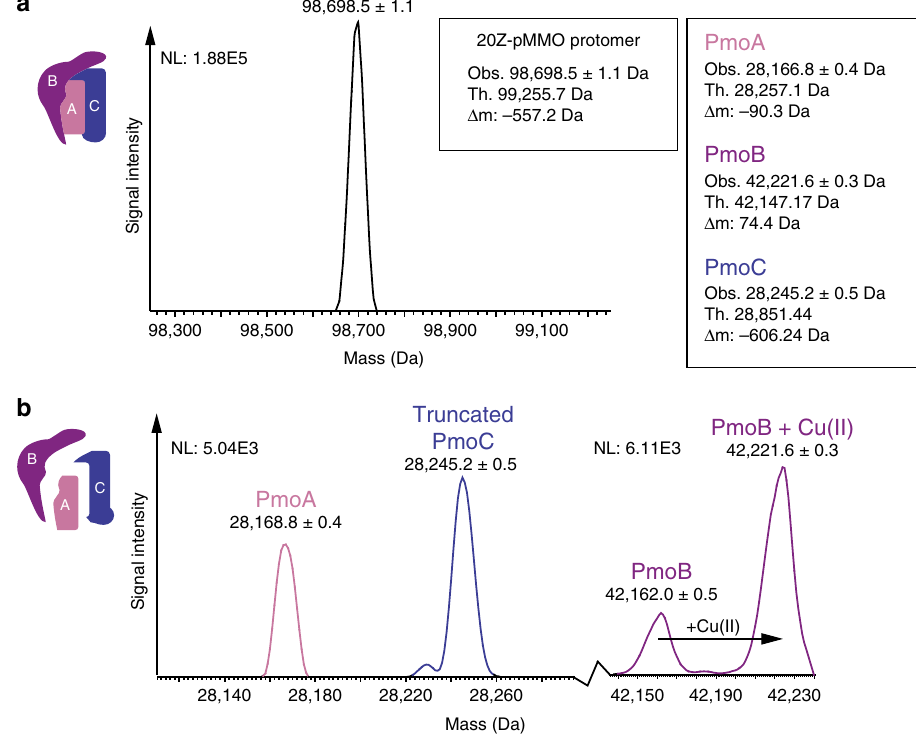
Fig. 3 nTDMS analysis of 20Z-pMMO in Triton X-100 micelles. a Deconvoluted MS 1 of 20Z-pMMO protomer upon ejection from a Triton X-100 micelle. Charge state deconvolution of the major species yields a mass of 98,696.5 ± 1.1 Da. The theoretical mass is derived from the unmodi fi ed subunits of pMMO and accounts for the cleavage of a known signal peptide in PmoB. b Deconvoluted MS 2 of 20Z-pMMO subunits ejected from the 16 + charge state of the protomer after activation by collisions with neutral gas. The spectrum shows detection of three species, labeled pink, purple, and blue and assigned to PmoA, PmoB, and PmoC, respectively. Adding the measured masses of the ejected subunits yields 98,633.6 Da, which is 62.4 Da smaller than the major protomer mass measured in the MS 1 . NL values re fl ect maximum signal intensity in the